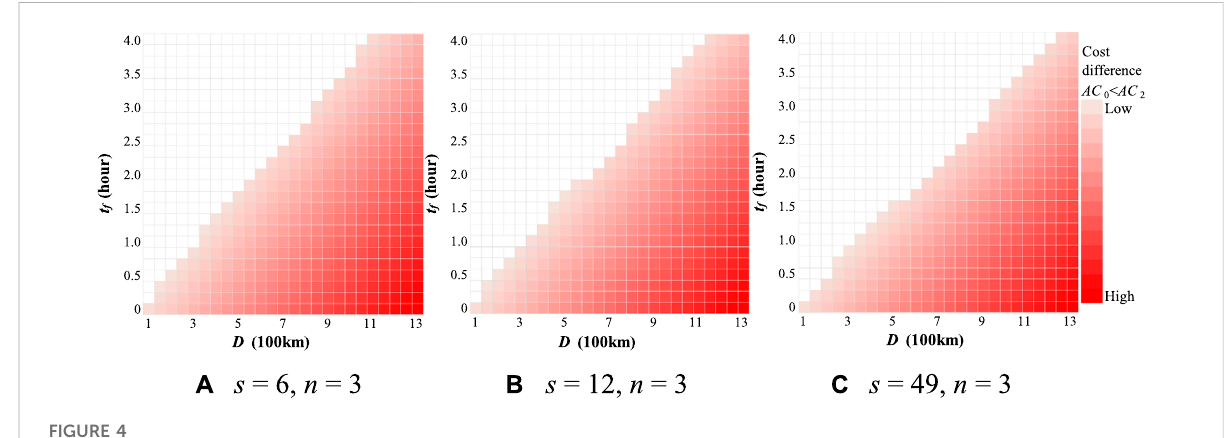
FIGURE 4 Cost comparison betweenCase 0 (single truck)and 2 (truck platooning) with changing inter-vehicle distance ( s ). (A) s = 6, n = 3 (B) s = 12, n = 3 (C) s = 49, n =